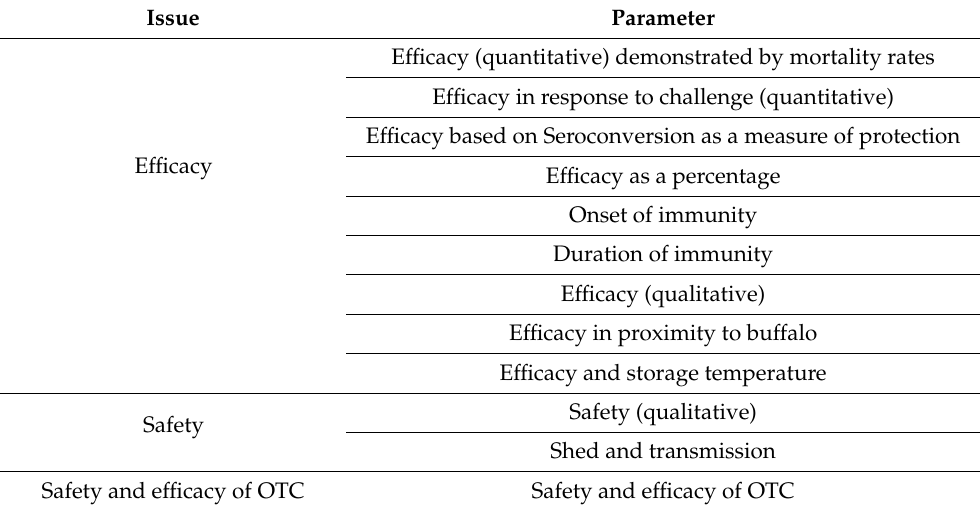
Table 4. Grouping of studies based on parameters relating to safety and efficacy